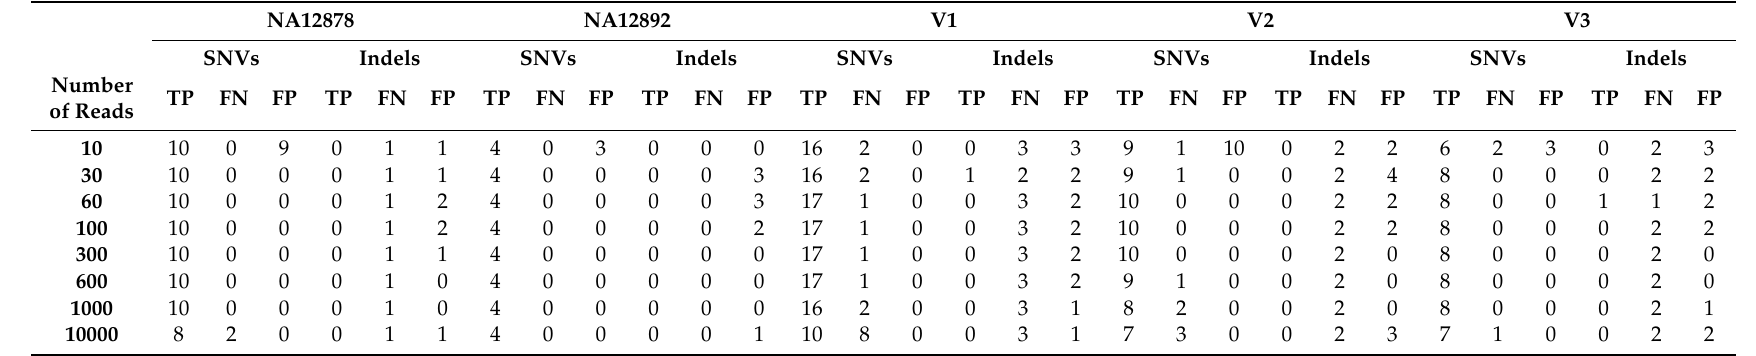
Table 4. Number of variants identified by the ONT platform. The total number of correct and spurious variants identified in the samples based solely on ONT data. SNVs = single nucleotide variants, indels = insertion / deletion variants, TP = true positives (identified by ONT and Illumina), FN = false negatives (only Illumina), FP = false positives (only